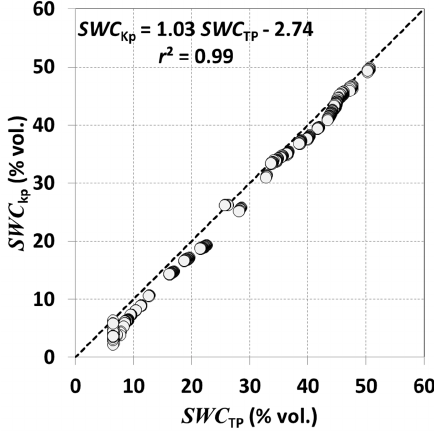
Figure 2. Thermal inertia (SWC Kp ) vs. measured (SWC TP ) soil water content (grey circles). The 1:1 line is also shown (dashed line).